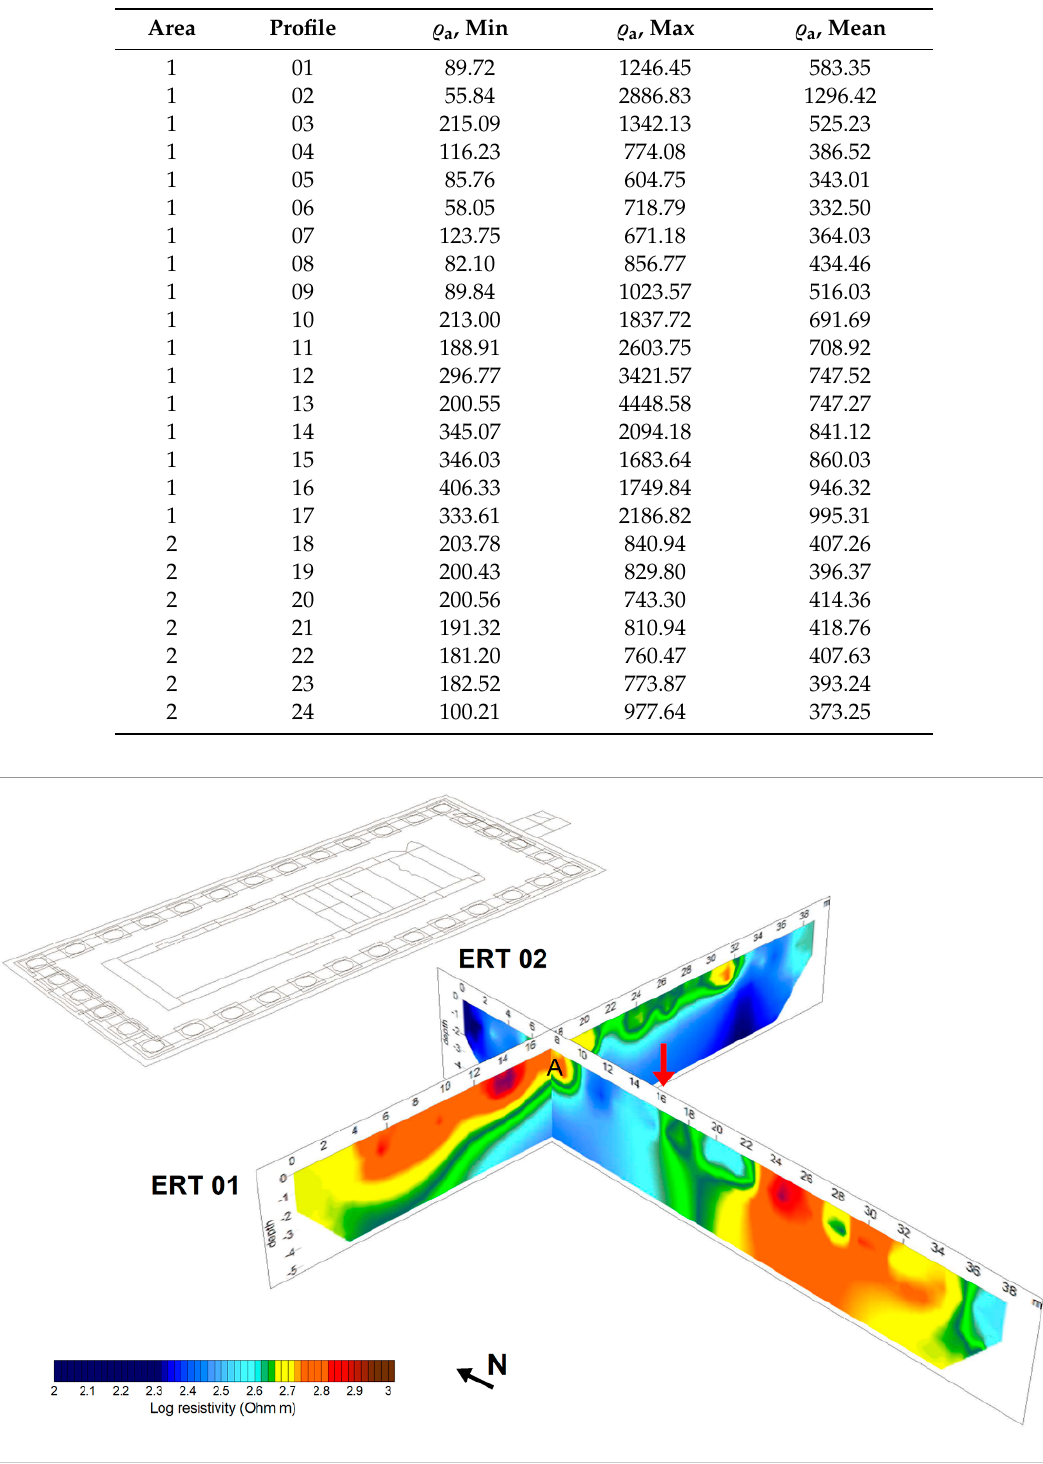
Table 1. Maximum and mean apparent resistivities in Ω m along the profiles.